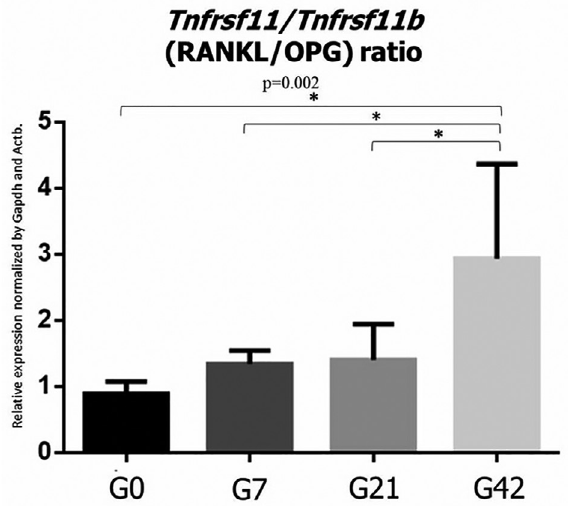
Figure 6- Graphical representation of Tnfrsf11:Tnfrsf11b ratio during AP progression. The asterisk demonstrates statistical difference (p<0.05) Table 1- Correlation between the mRNA expression of the